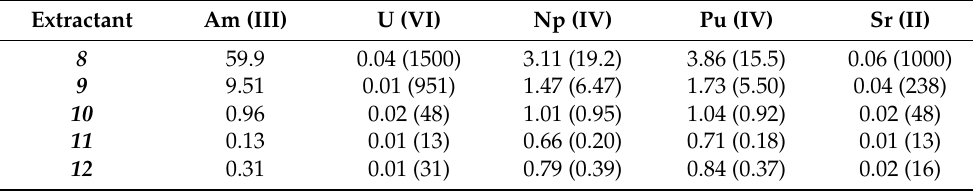
Table 2. Distribution ratios and separation factor data β Am/Me (given in